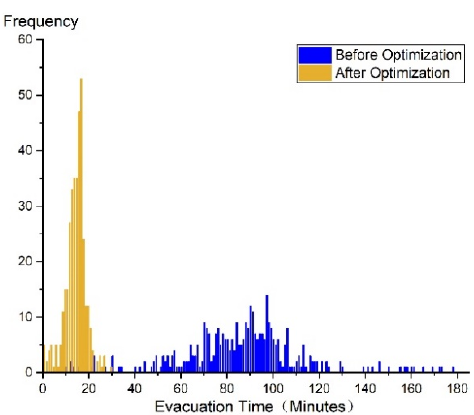
Figure 12. The comparison of the frequency distributions of the evacuation time before and after